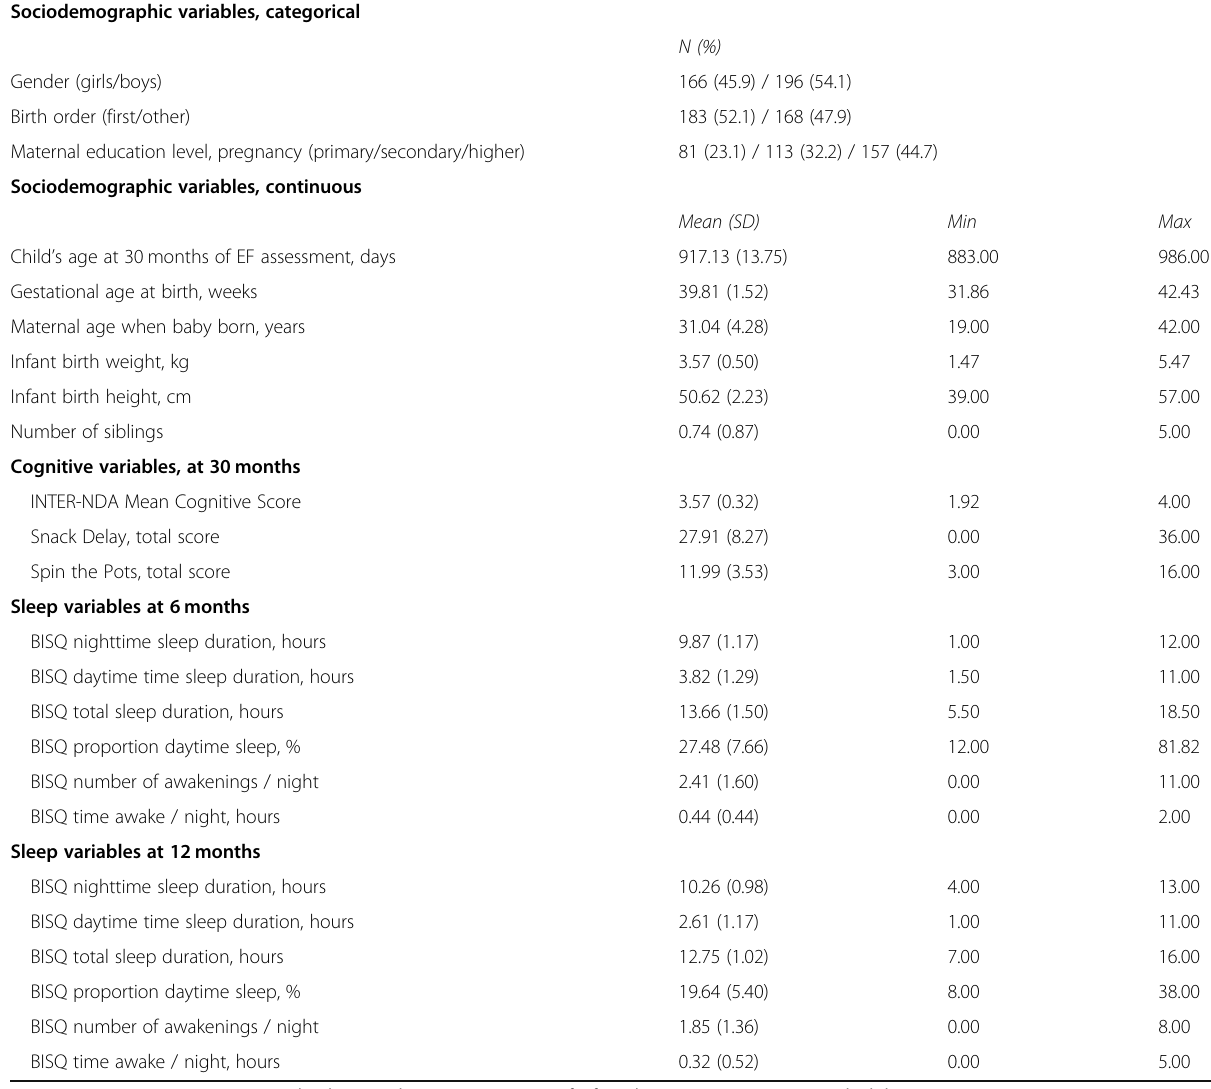
Table 1 Sociodemographic, cognitive and sleep variables at 6 and 12 months Sociodemographic variables, categorical Gender